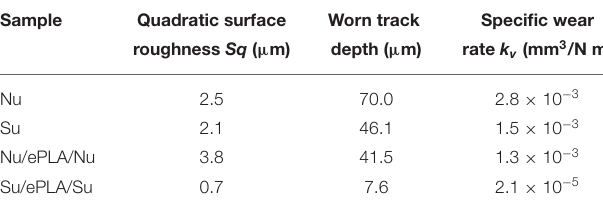
TABLE 3 | Surface roughness, worn depth and Specific wear rate of the worn tracks of the different specimens. Sample